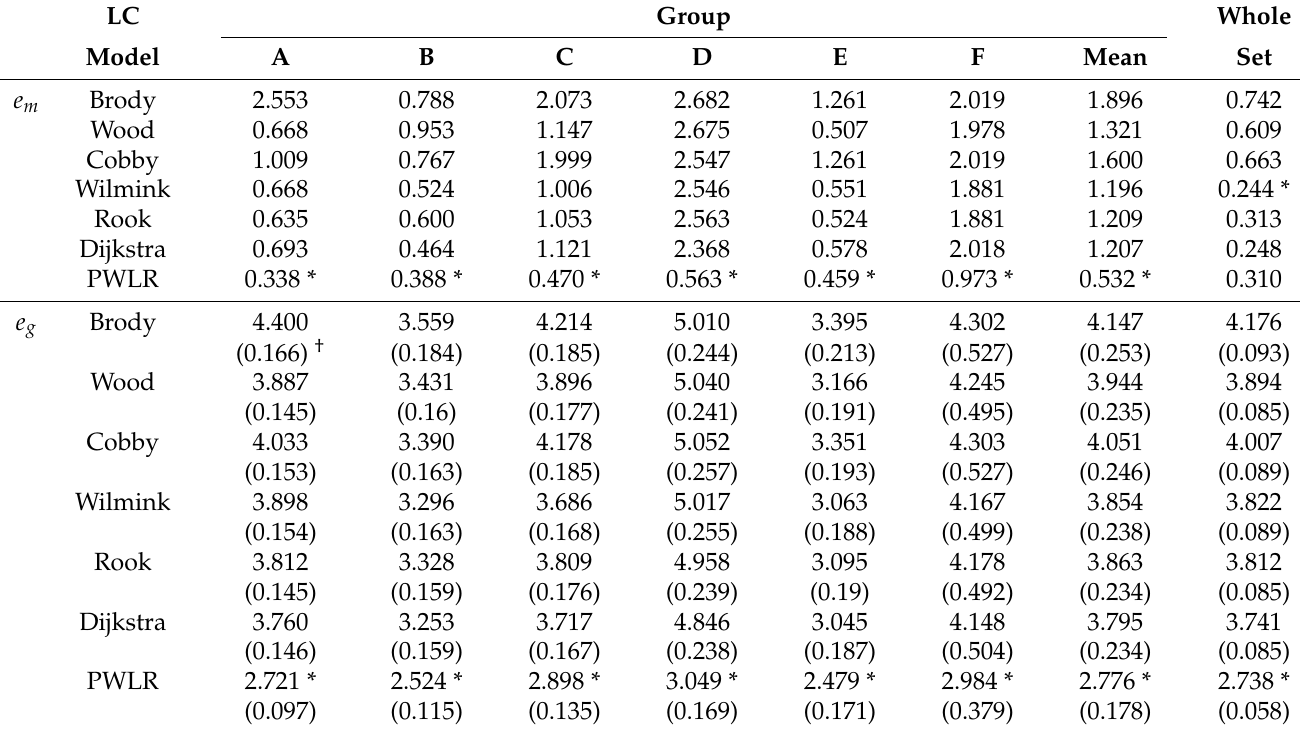
Table 4. Mean and intra-fitting errors for the dataset.